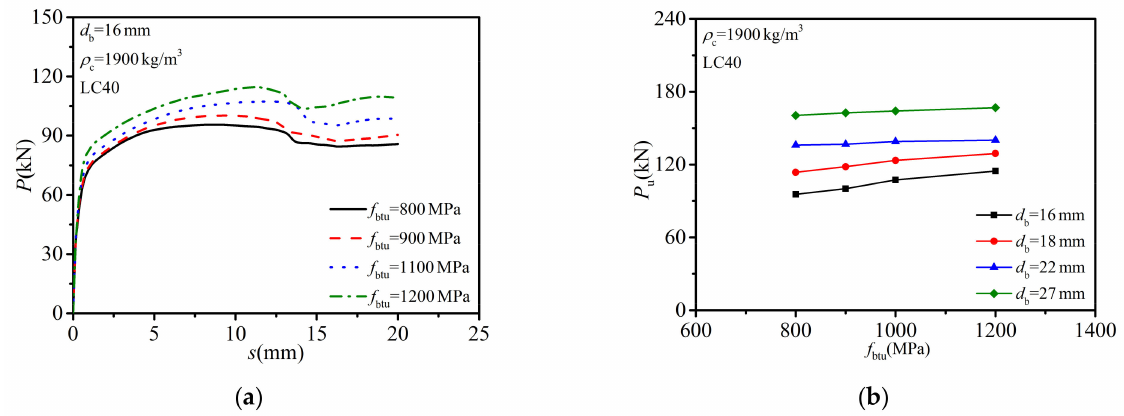
Figure 17. Influence of bolt tensile strength ( f btu ): ( a ) force-slip relationship; ( b ) shear capacity.